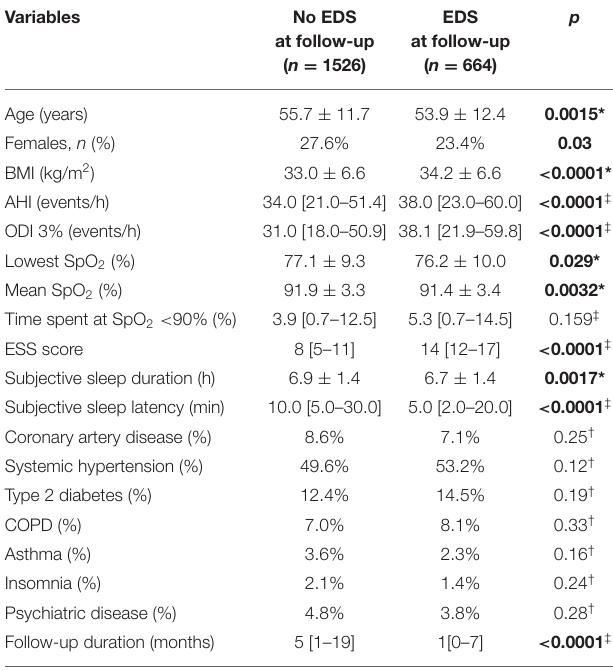
* one-way ANOVA (means ± SD); ‡ Mann-Whitney U-test test (medians and interquartile ranges); † χ 2 test (percent). Significantly different variables are marked in